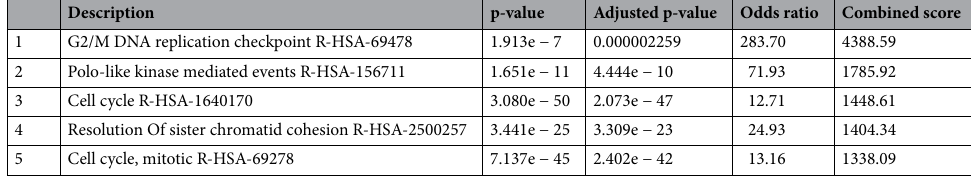
Table 4. Reactome pathway up-regulated DEGs enrichment analysis.